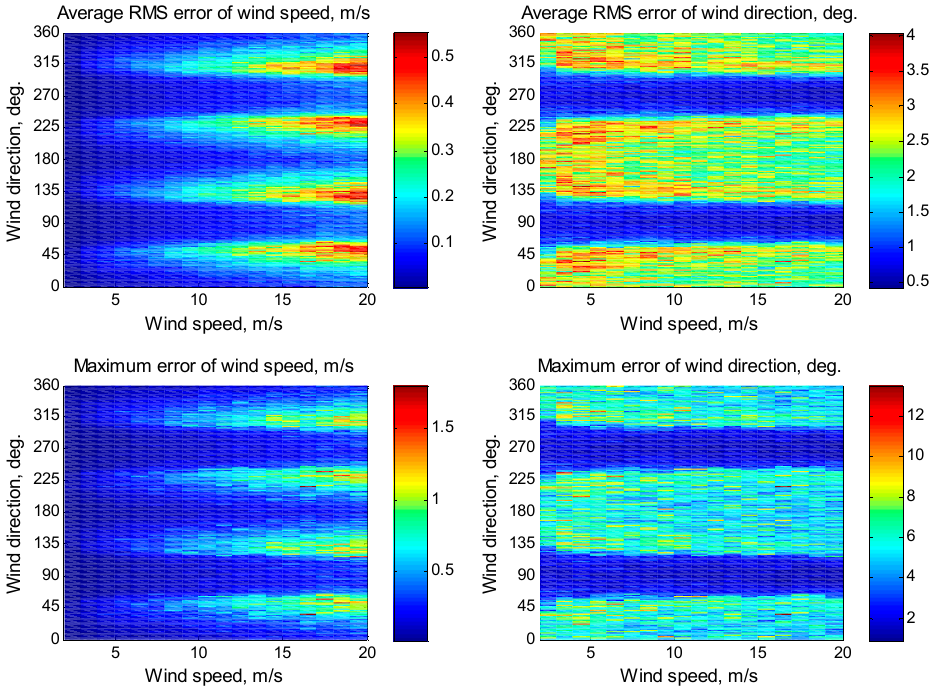
Figure 13. Simulation results for the mounting angle of a beam axis in the horizontal plane of 15°